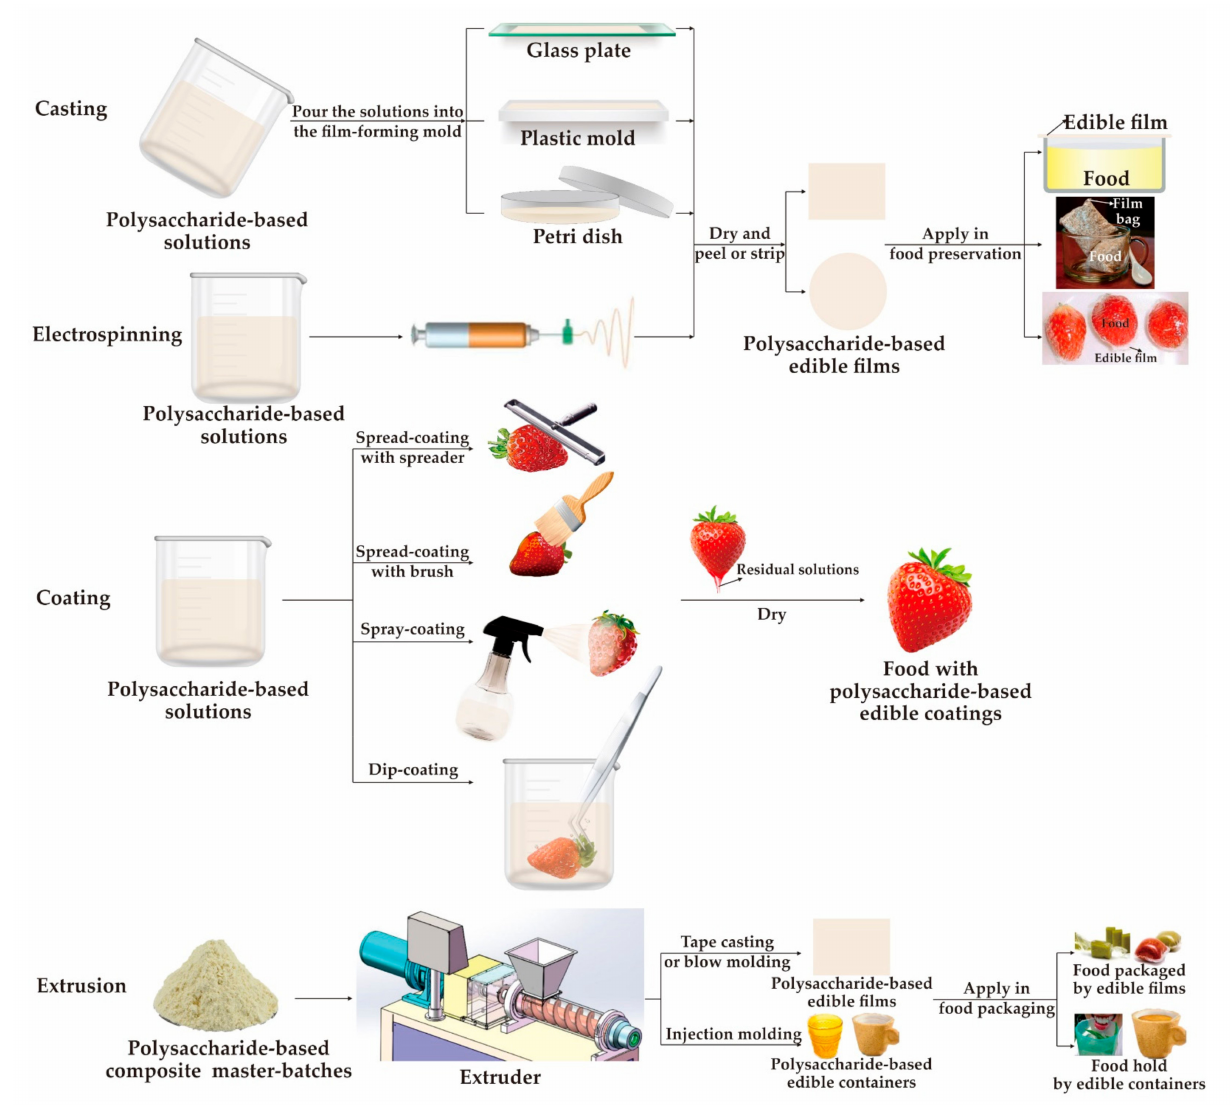
Figure 3. Different manufacture methods of polysaccharide-based edible